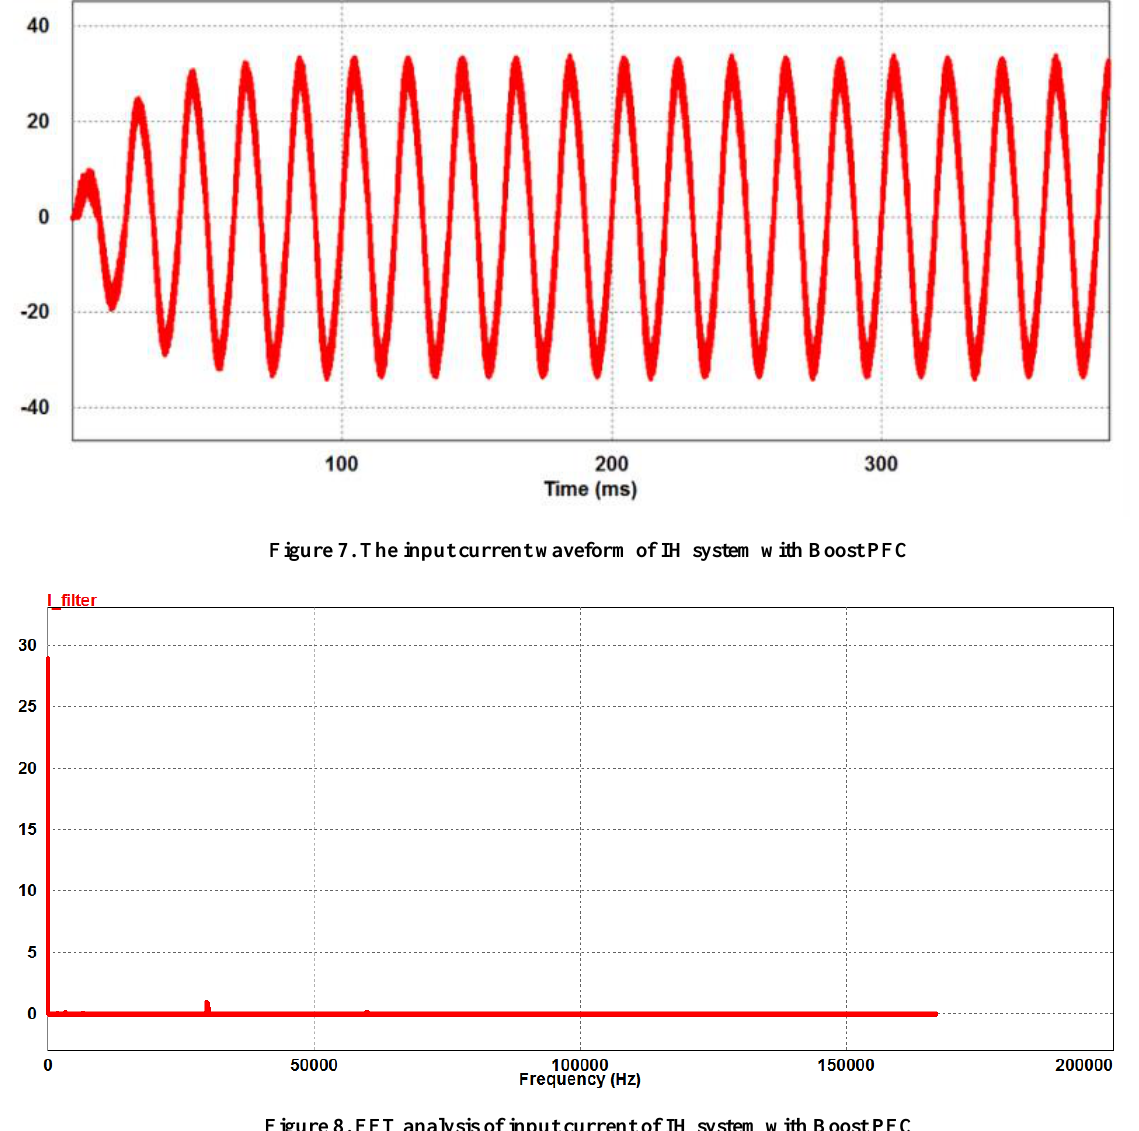
Figure 8. FFT analysis of input current of IH system with Boost